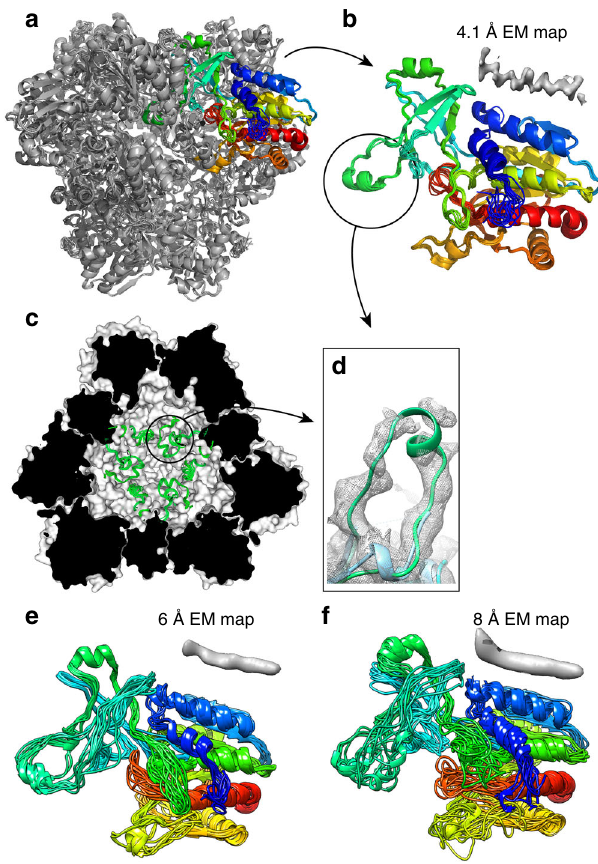
Fig. 4 Structure of the TET2 dodecamer from EM/NMR. a Overall view of the dodecamer, highlighting in color one out of the 12 modeled subunits, obtained from joint re fi nement of 12 subunits against NMR and EM data. b Bundle of 10 structures of one monomer, with an accuracy of 0.7 Å (backbone RMSD relative to crystal structure). The loop region, residues 120 – 138, which has not been modeled in the crystal structure (PDB 1y0r) is encircled in ( b ), and shown in the view of the interior of the cavity ( c ) and as a zoom ( d ). The EM map around the loop region, seen by cryo-EM ( d ) is of signi fi cantly higher intensity than in the 100 K crystal structure (1y0r). The backbone structure in both panels is from the present NMR/EM